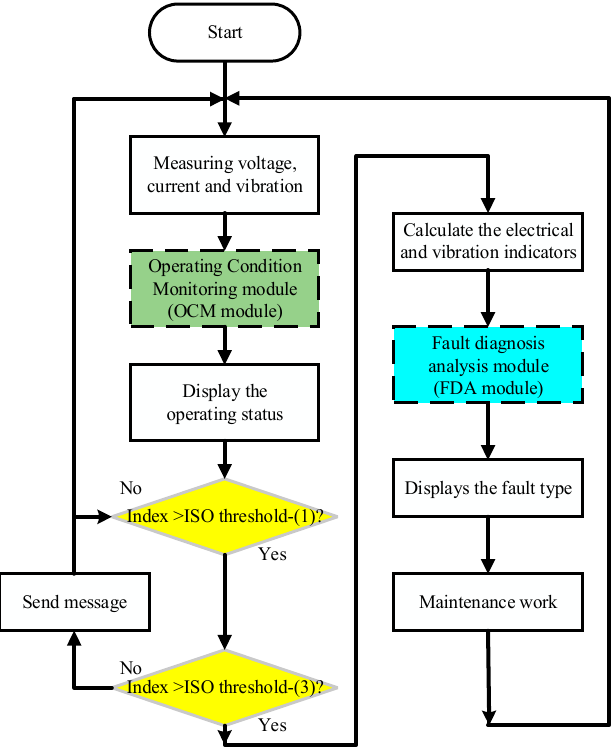
Figure 3. Overall hybrid approach flow chart.